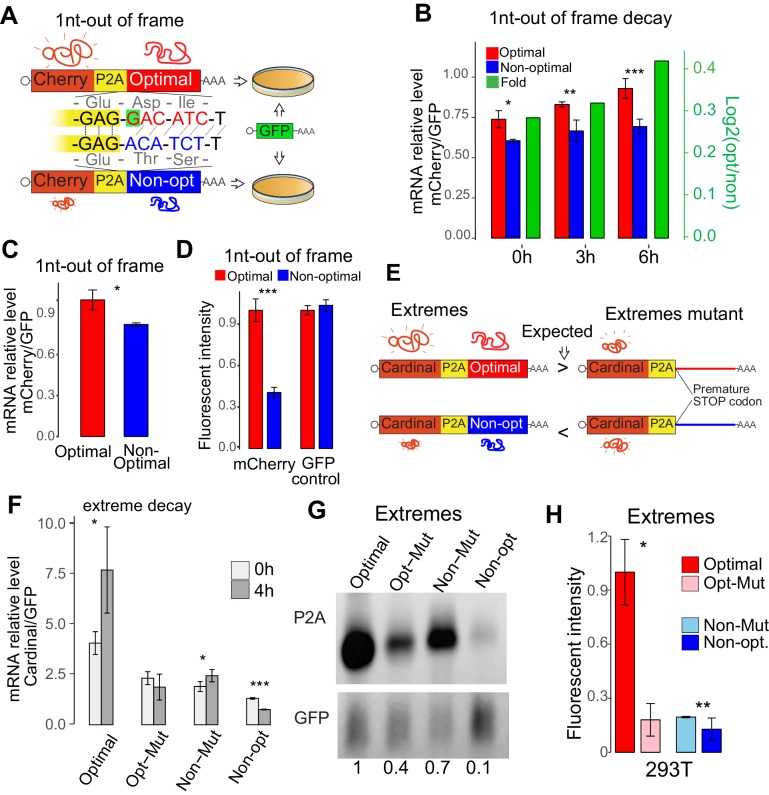
Codon identity affects mRNA stability in human lines.(A) Scheme of the 1nt-out of frame reporters: two mRNAs that differ in the codon composition due to a single nucleotide (G in red, highlight with green) which creates a frameshift. The encoding mCherry fluorescent protein was followed by a cis-acting hydrolase elements (P2A) and then by the coding region enriched in optimal or non-optimal codons due to the frame shift. P2A causes ribosome skipping, therefore, the mCherry is not fused to the optimal or non-optimal encoded proteins. The reporter pairs were co-transfected with a vector encoding for GFP as internal control. (B) The 1nt-out of frame reporter enriched in optimal codons displayed higher stability than its non-optimal counterpart. Cells are treated with Actinomycin D 24hs after transfection, samples are collected at different timepoint to measure RNA level after blocking transcription, qPCR result is normalized with GFP internal control. *p<0.05, **p<0.01 and ***p<0.005 Unpaired t.test for all the panels. (C) qRT-PCR results showing that the 1nt-out of frame reporter enriched in optimal codons present higher level of RNA than its non-optimal counterpart 24 hr post-transfection. (D) The 1nt-out of frame reporter enriched in optimal codons displayed higher mCherry intensity than its non-optimal counterpart measure by cytometry. None significant differences were observed in the internal GFP control. (E) Scheme of the ‘Extreme’ reporters. Pairs of mRNA differing only in single mutation causing a premature stop codon. Each mRNAs contain Cardinal fluorescent protein coding region followed by a cis-acting hydrolase elements (P2A) and coding region enriched in optimal or non-optimal codons. Their counterparts (referred as mutants) contain a single mutation that cause a premature stop codon upstream the region enriched in optimal or non-optimal codons. Therefore, the translational competent reporter enriched in optimal codons should evidence higher level of expression that its mutant counterpart. And the reporter in non-optimal mRNA should express less than its counterpart translational incompetent. (F) qRT-PCR results showing relative stability of extreme reporters. Cells are treated with Actinomycin D 24hs after transfection, samples are collected at different timepoint to measure RNA level after blocking transcription, GFP is used as internal control to normalize qPCR result. The extreme translation-competent reporter enriched in optimal codons presented higher stability than its translation deficient counterpart (Mut). And the translation-competent reporter enriched in non-optimal codon was more unstable than its translation deficient counterpart (Mut). (G) Northern-blot showing that the extreme reporter enriched in optimal codons presented higher RNA level that its mutant counterpart. Contrary, the mRNA enriched in non-optimal codons present lower mRNA level than is mutant counterpart. GFP mRNA signal was used as internal control. Relative normalized quantifications are indicated. (H) The extreme reporter enriched in optimal codons displayed higher fluorescent intensity than its mutant counterpart measure by cytometry. The reporter enriched in non-optimal codons evidenced lower fluorescent intensity than its mutated pair.
10.7554/eLife.45396.009Figure 2—source data 1.Reporter sequences and oligos used for Figure 2.